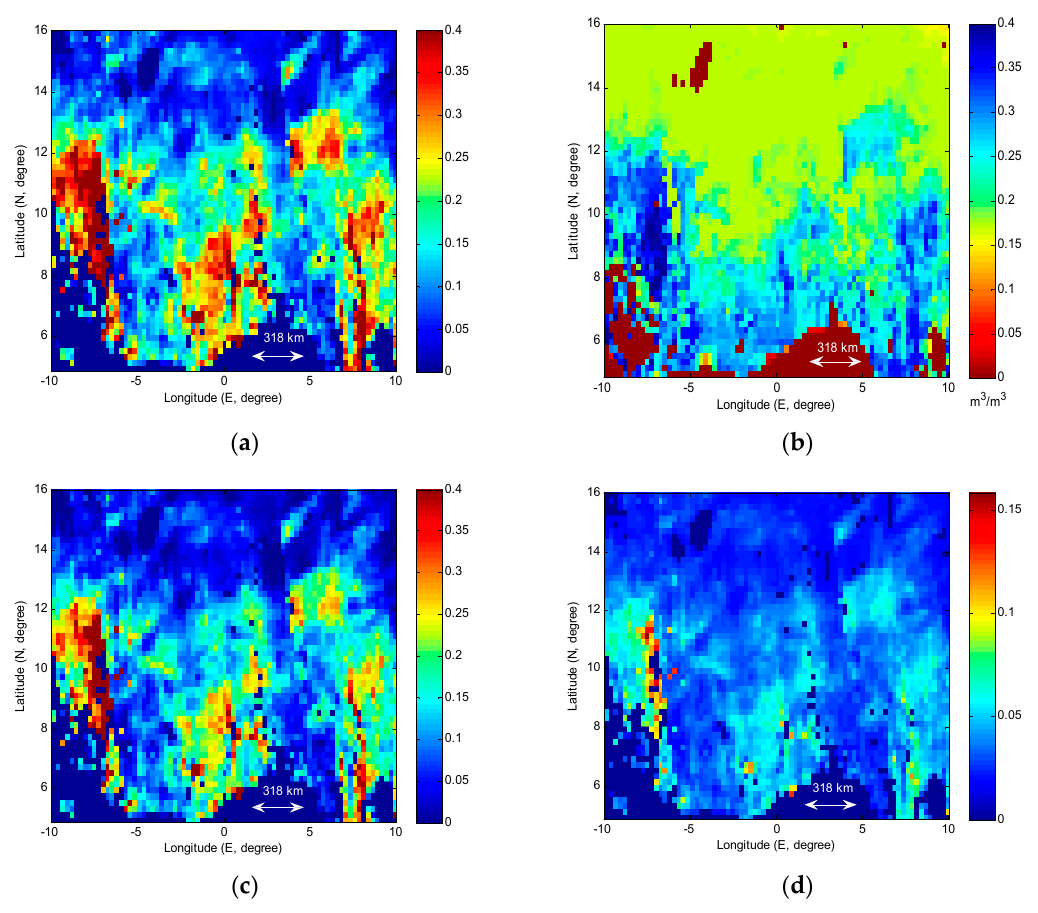
Figure 6. Spatial distribution of surface soil moisture, m 3 /m 3 (red is wet, while blue is dry): ( a ) SMOS product; ( b ) CDF matching; ( c ) ensemble method; and ( d ) difference between before and after bias correction [52].